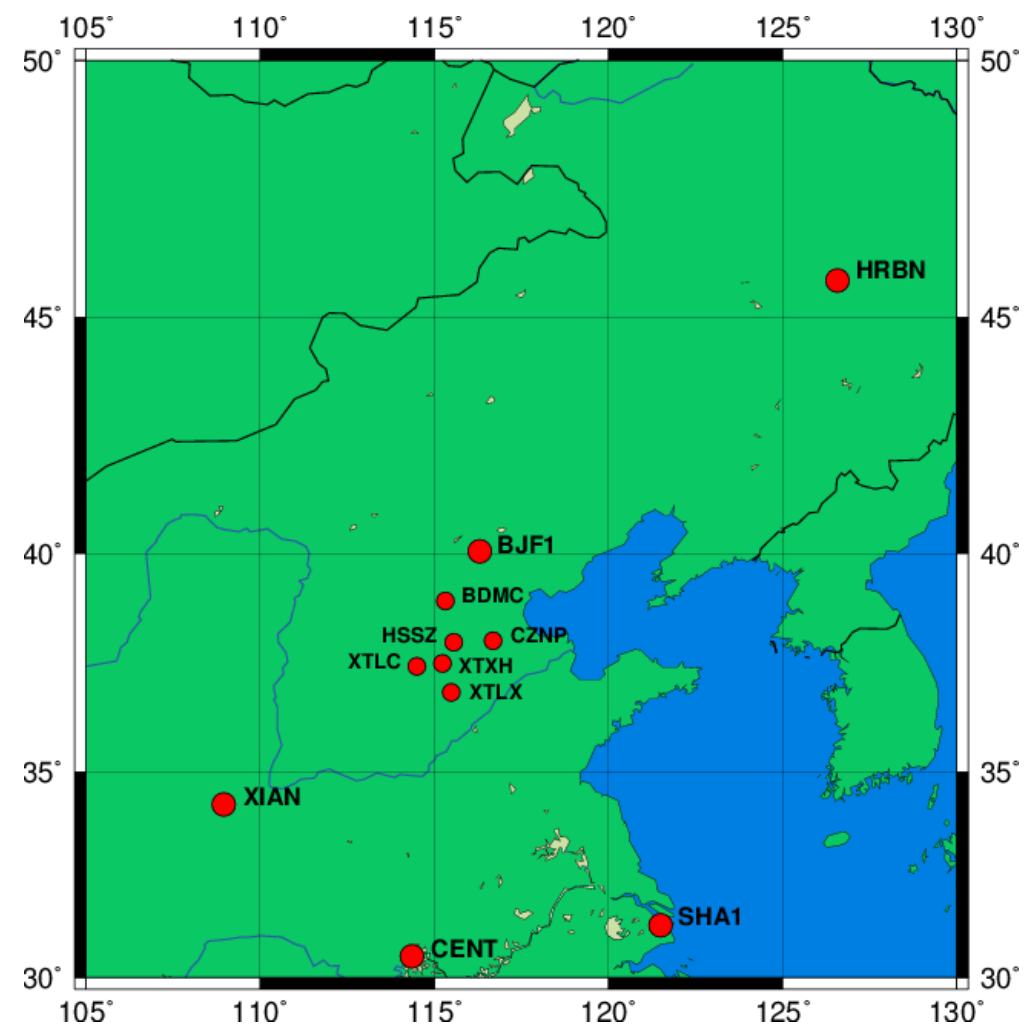
Figure 2. The local GNSS network of medium inter-station distance equipped with GPS- and BDS-capable dual-frequency receivers for ZTD